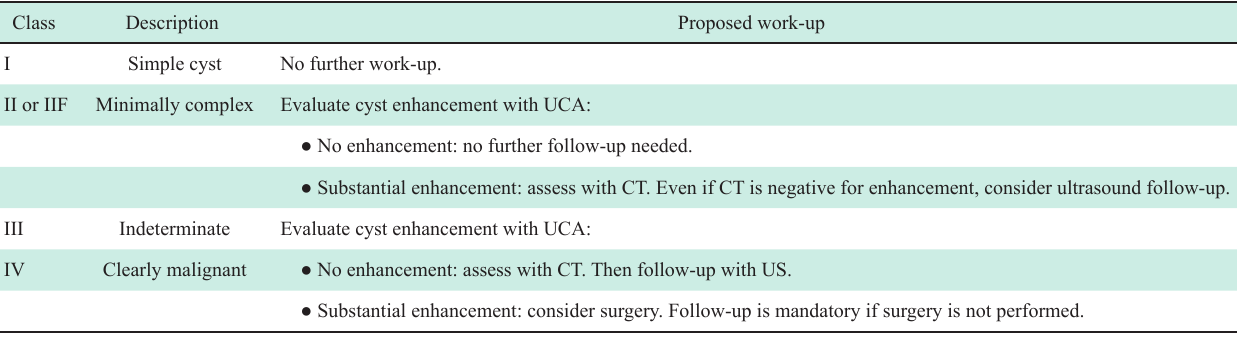
Table 2 Modified bosniak classification system using